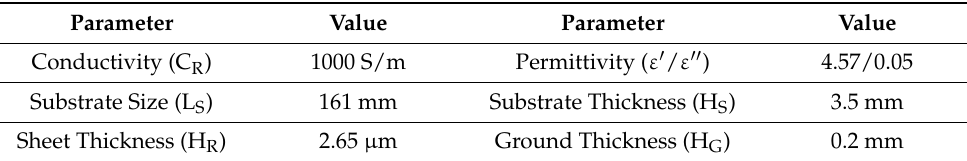
Figure 11. Design of the Salisbury screen absorber. Table 4. Design parameters and values of the Salisbury screen